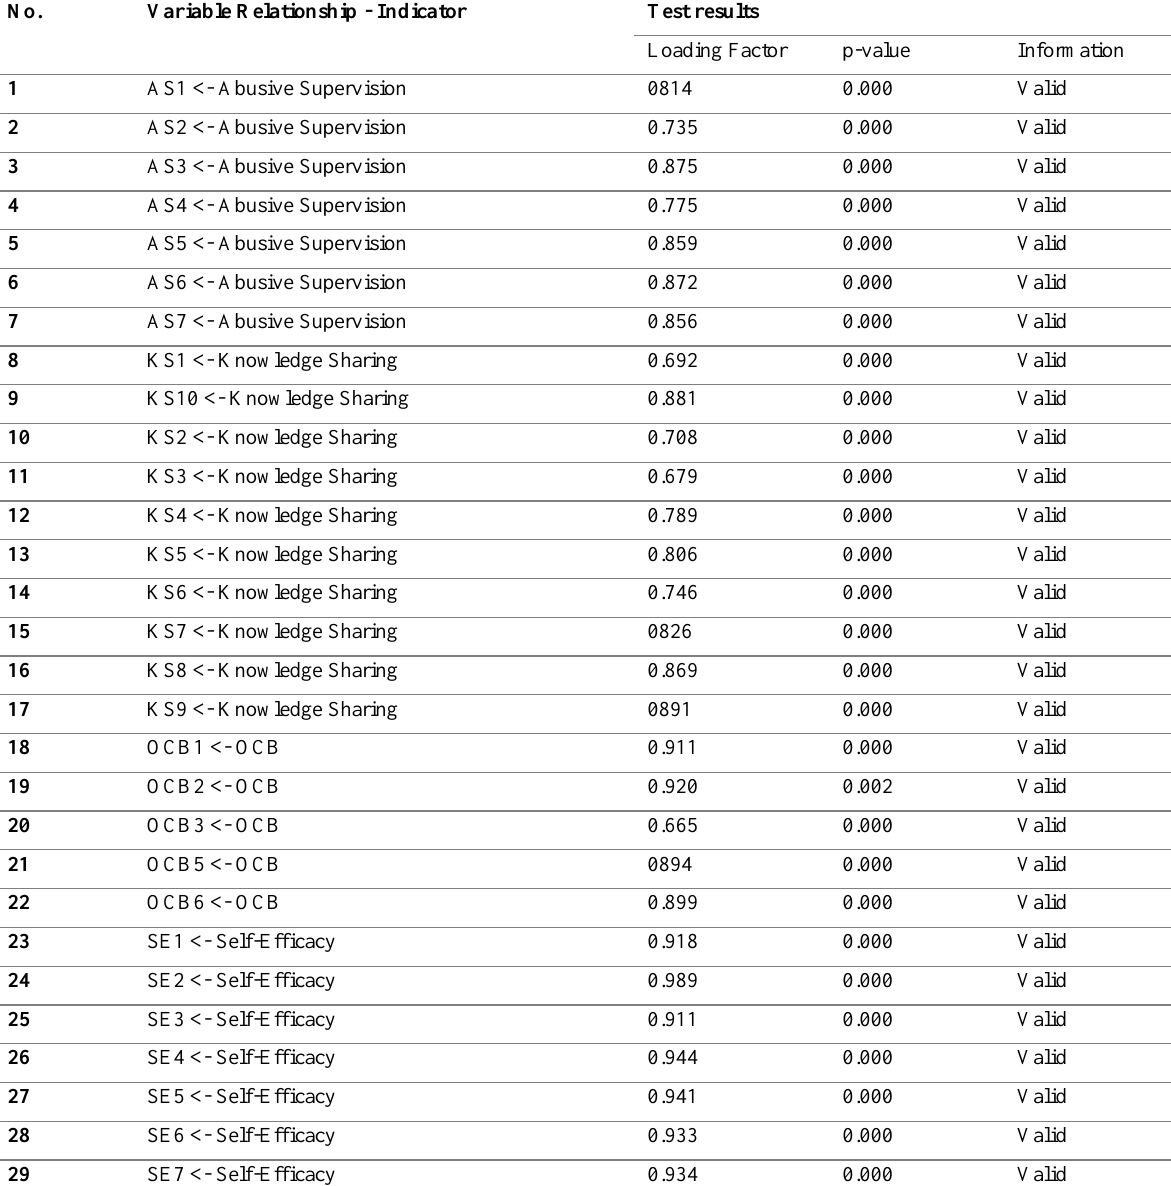
Table 2: Indicator Test Outer Loadings